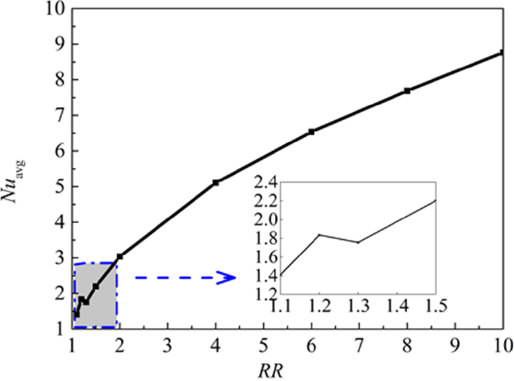
Figure 20. Average Nusselt number ( Nu avg ) of the inner wall for different radius ratios ( RR ) at Ra = 5 × 10 4 , Da = 10 − 2 , ϕ = 0.05, d sp = 50 nm, and ε = 0.5.